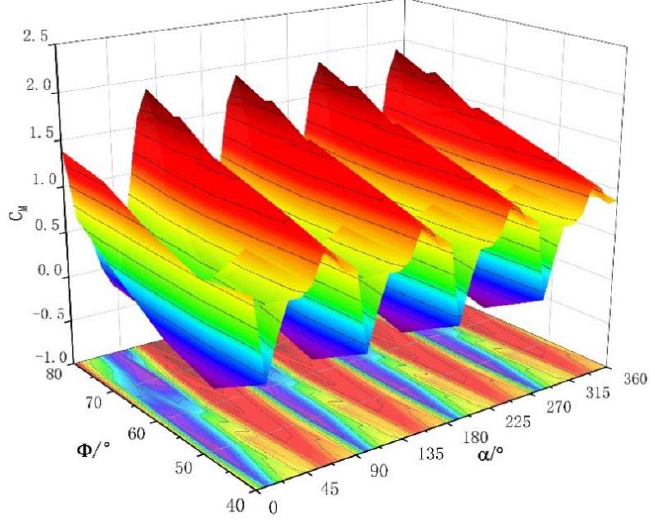
Figure 7. The effect of changes in Φ and α on C M.